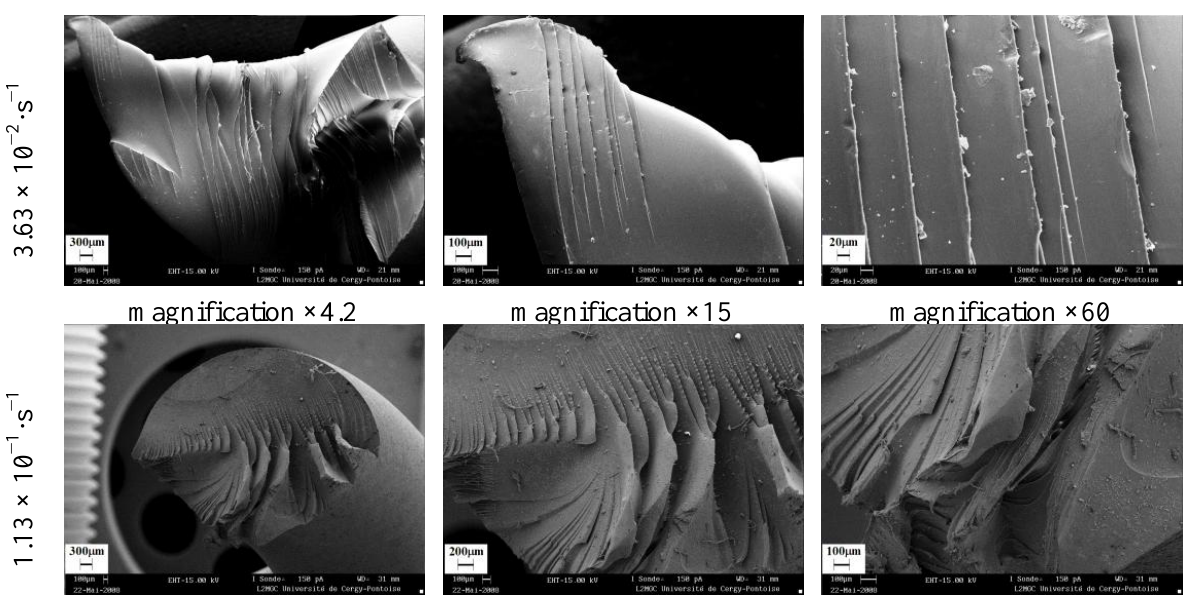
Figure 28. Fractography of PC torsion test for different equivalent strain